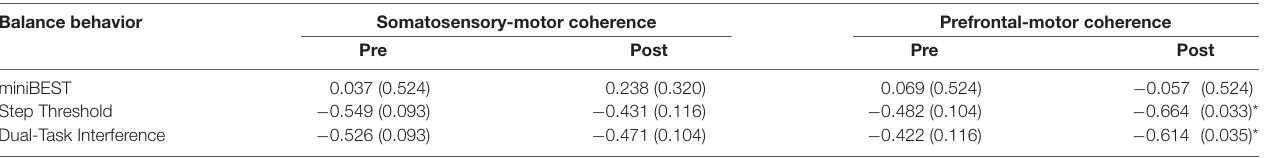
TABLE 2 | Statistical analyses for relationships between cortical beta coherence vs. balance behavior. Balance